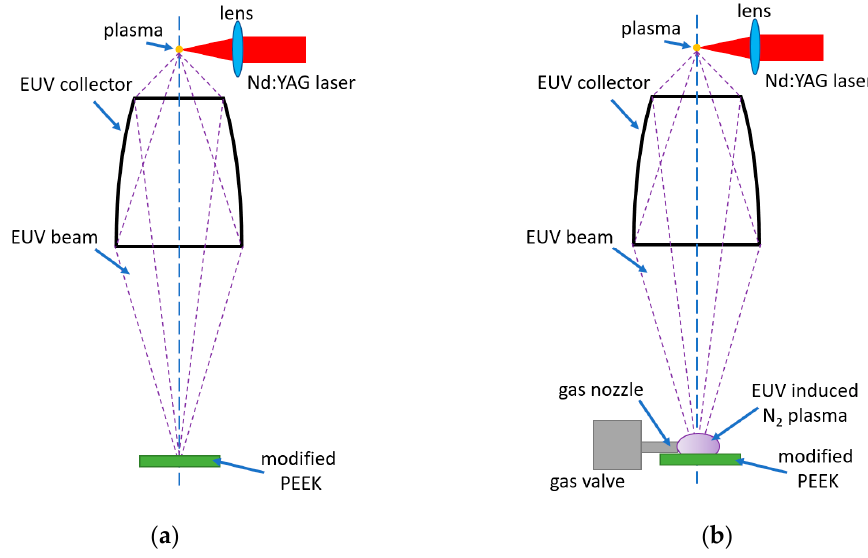
Figure 2. The scheme of experimental arrangement: ( a ) polyetheretherketone (PEEK) sample modified with EUV radiation, ( b ) PEEK sample modified with EUV radiation and nitrogen plasma.